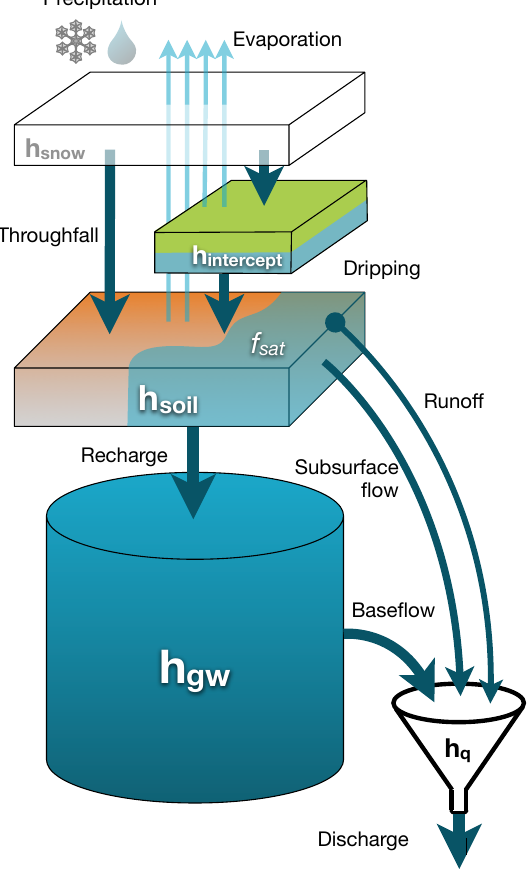
Figure 2. Schematic structure of the applied hydrological